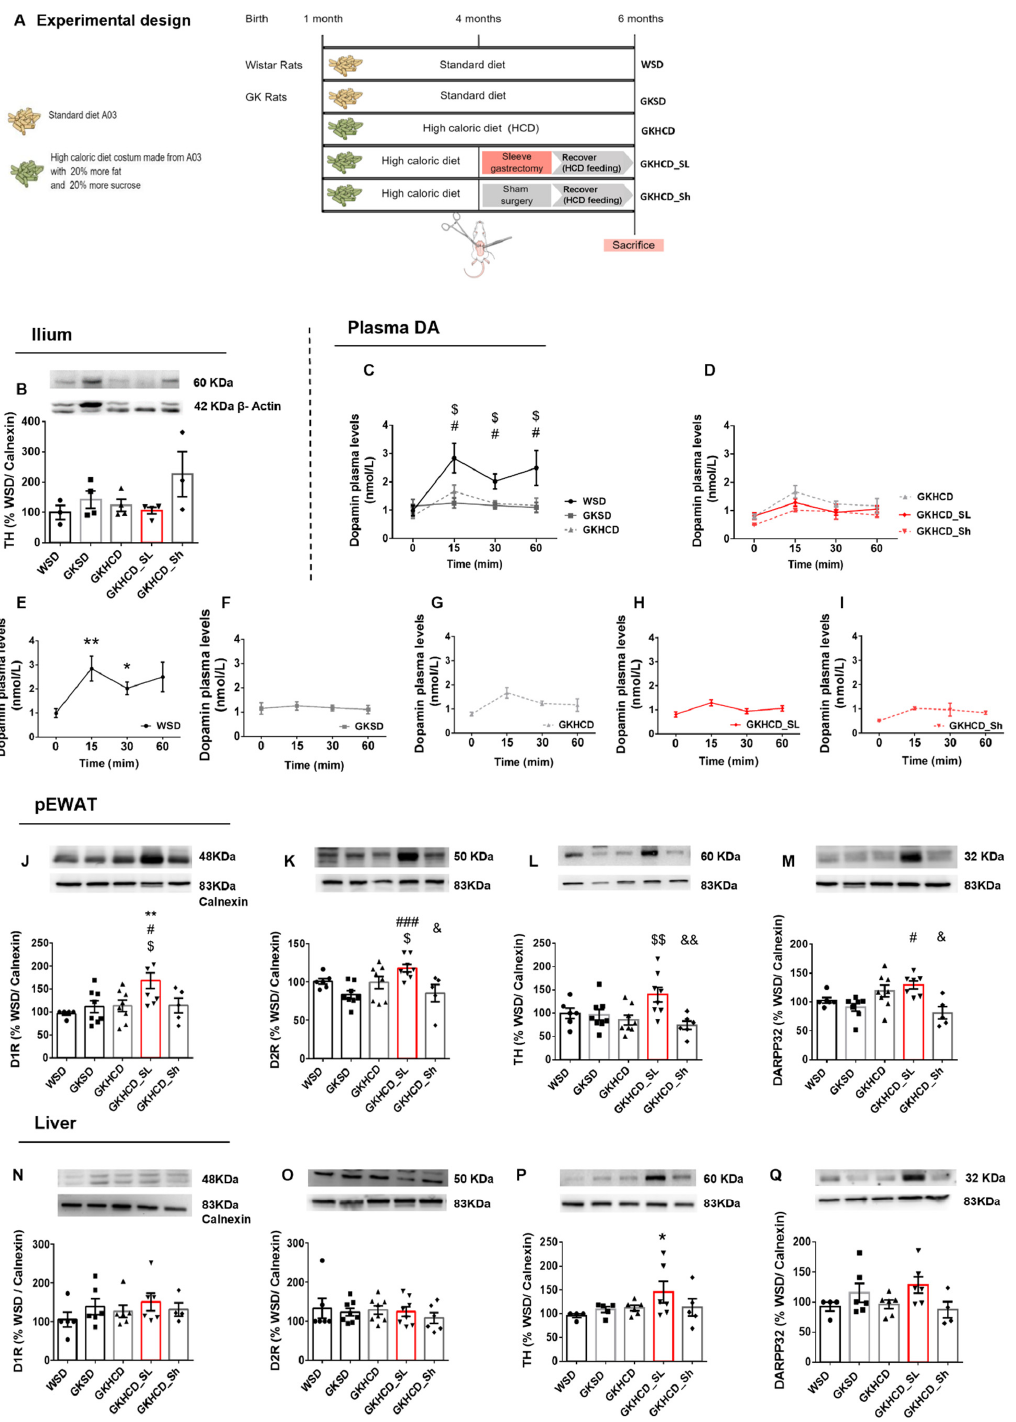
Figure 2. Gut remodeling improved dopaminergic signaling in adipose tissue of animals submitted to sleeve gastrectomy. Vertical sleeve gastrectomy (experimental design depicted in ( A )) did not